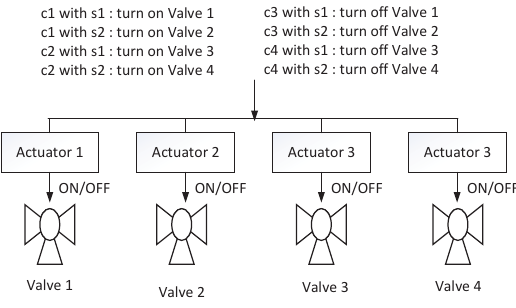
Figure 2. An example: explaining different attack modes.